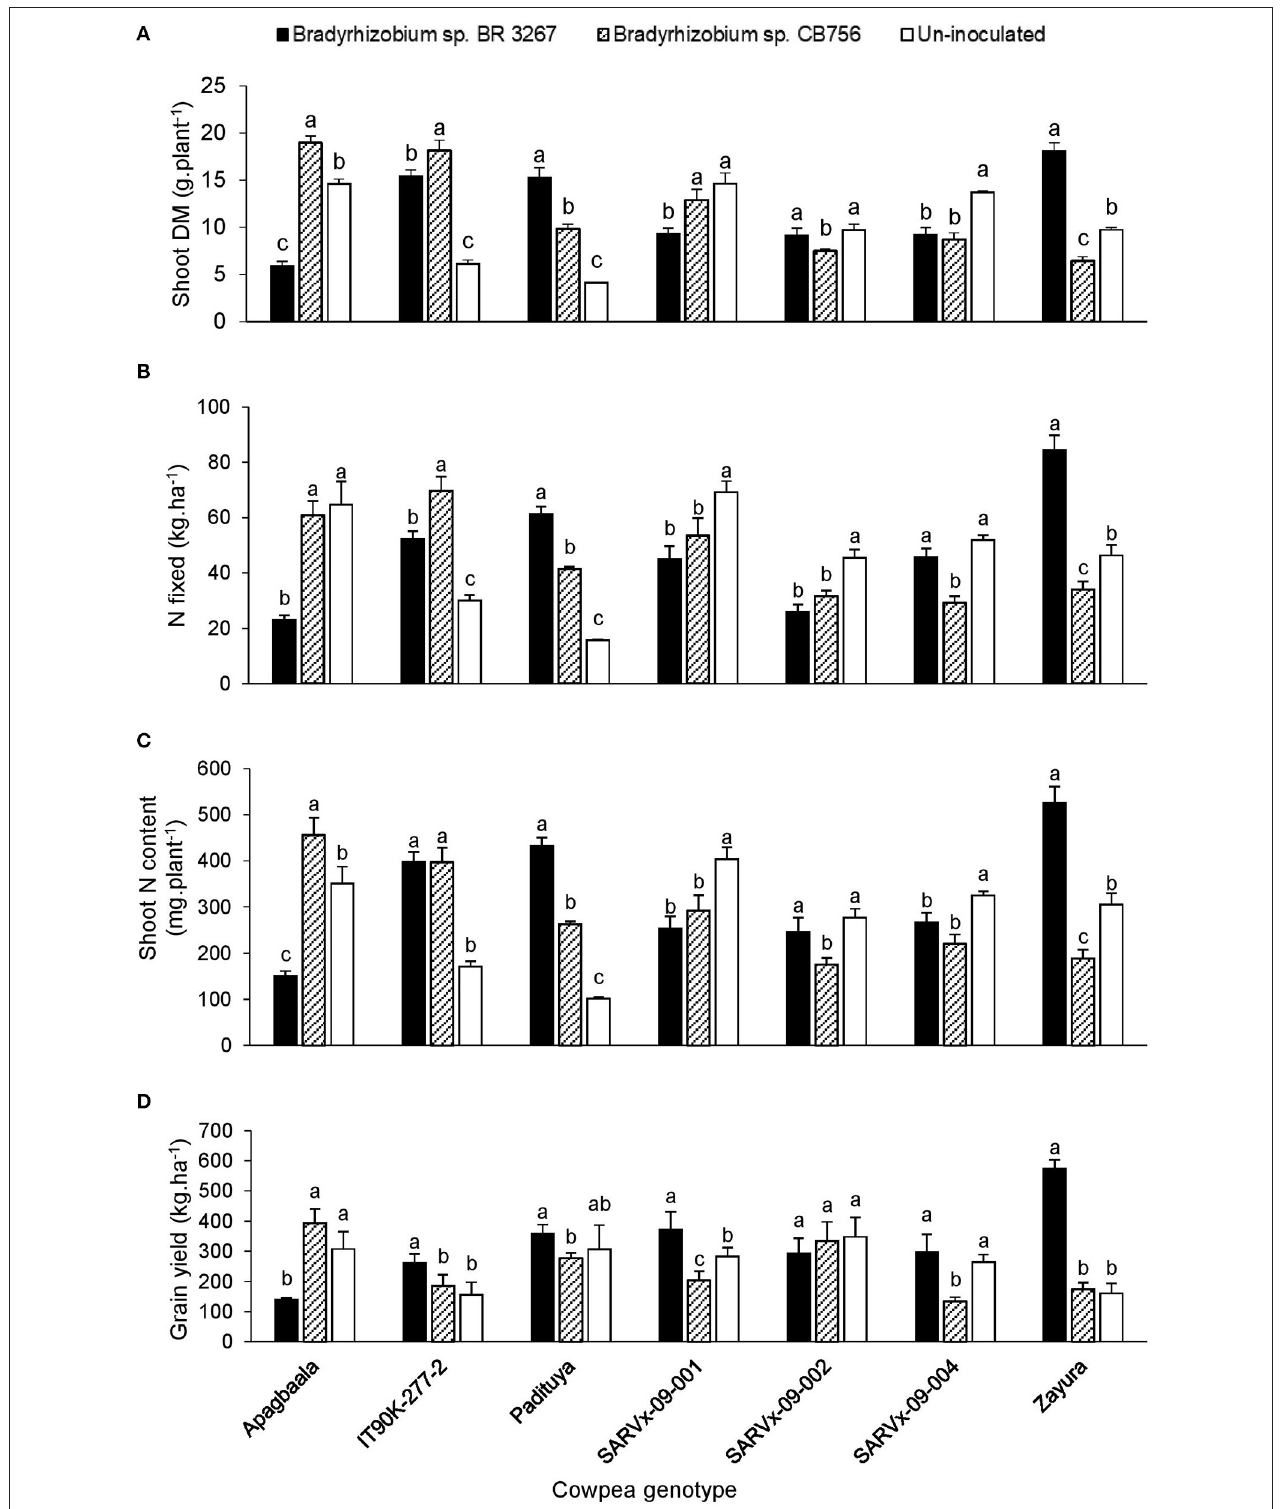
FIGURE 3 | The interactive effect of genotype x inoculation on (A) shoot dry matter, (B) N-fixed, (C) N content, and (D) grain yield of 7 cowpea genotypes planted in Gbalahi in 2013. For each genotype, bars with dissimilar letters are significantly different at p ≤ 0.05. Error bars represent standard errors.